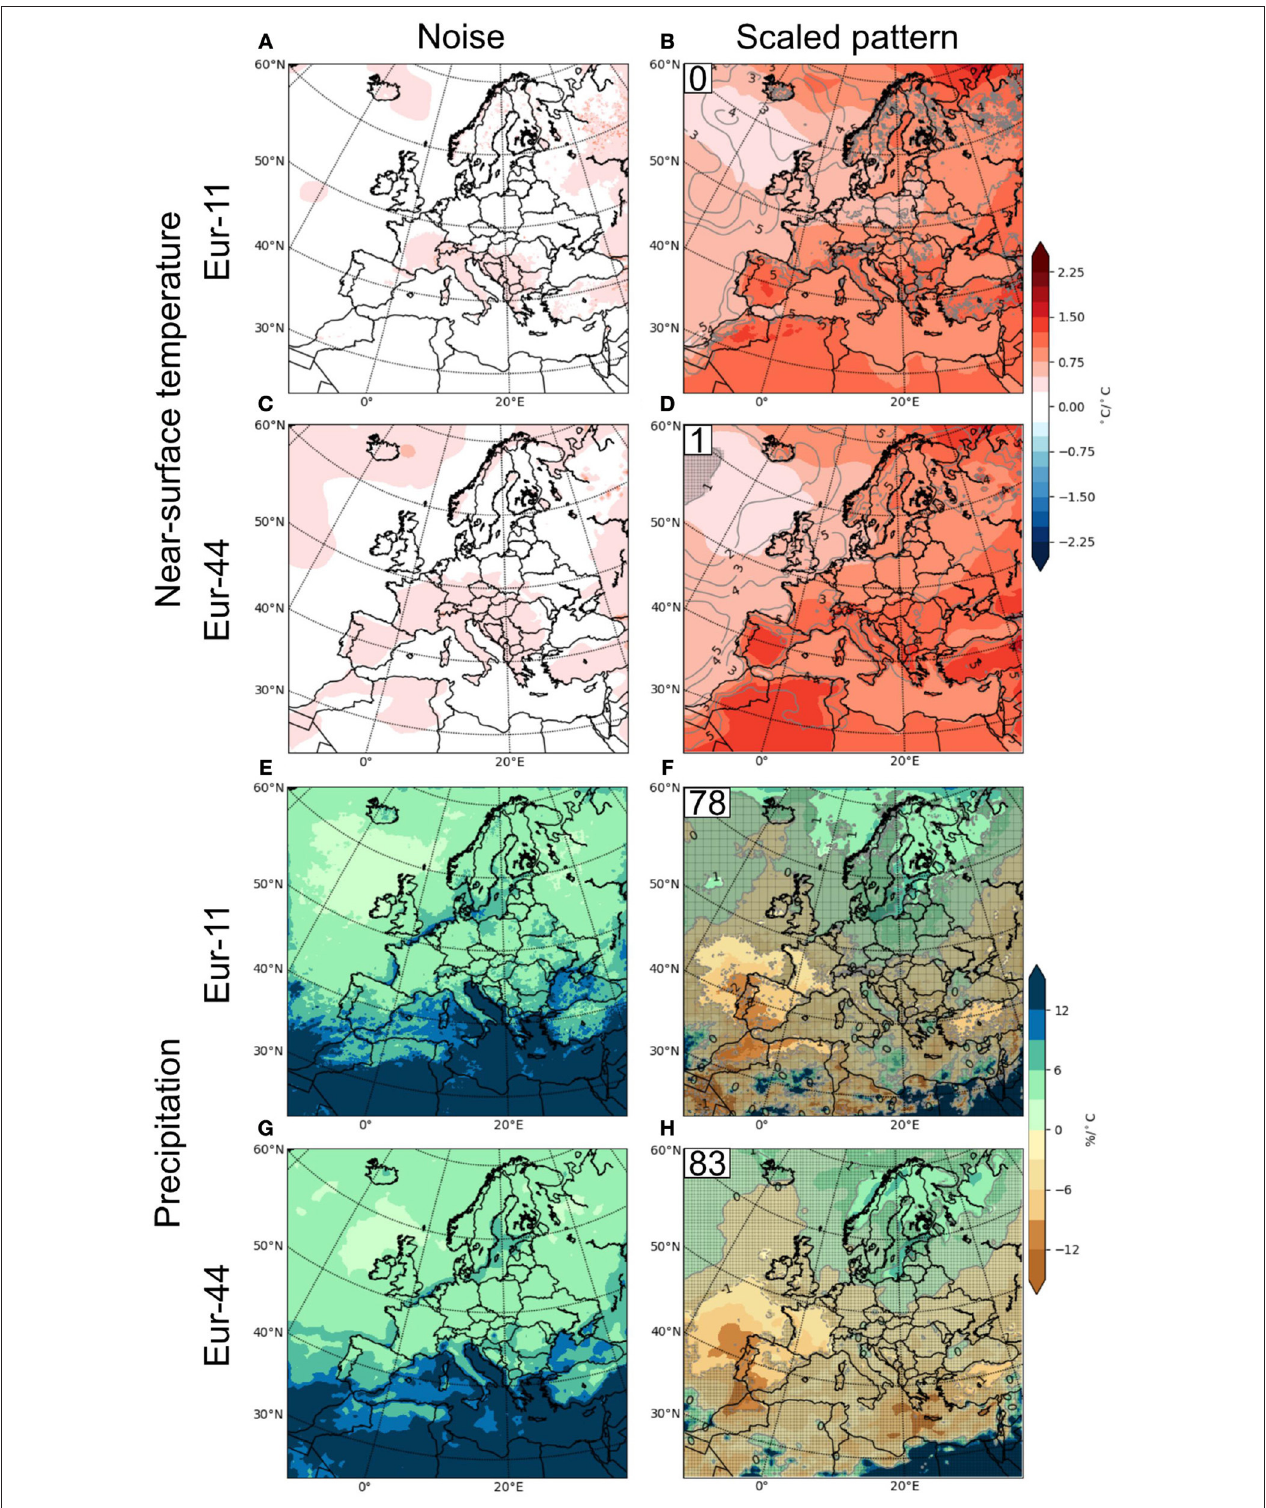
FIGURE 4 | As for Figure 3 but for